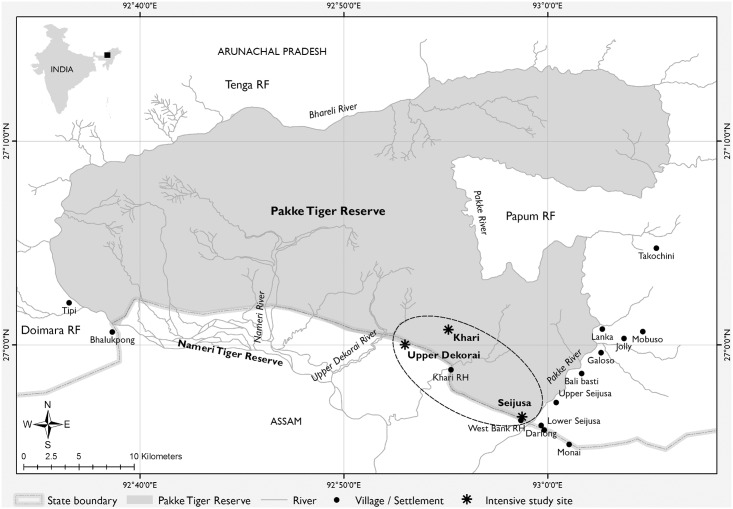
A map of the study area, Pakke Tiger Reserve, located in the Eastern Himalaya, India.The intensive study sites (shown as three points inside the ellipse) were situated in the south-eastern part of the Reserve.